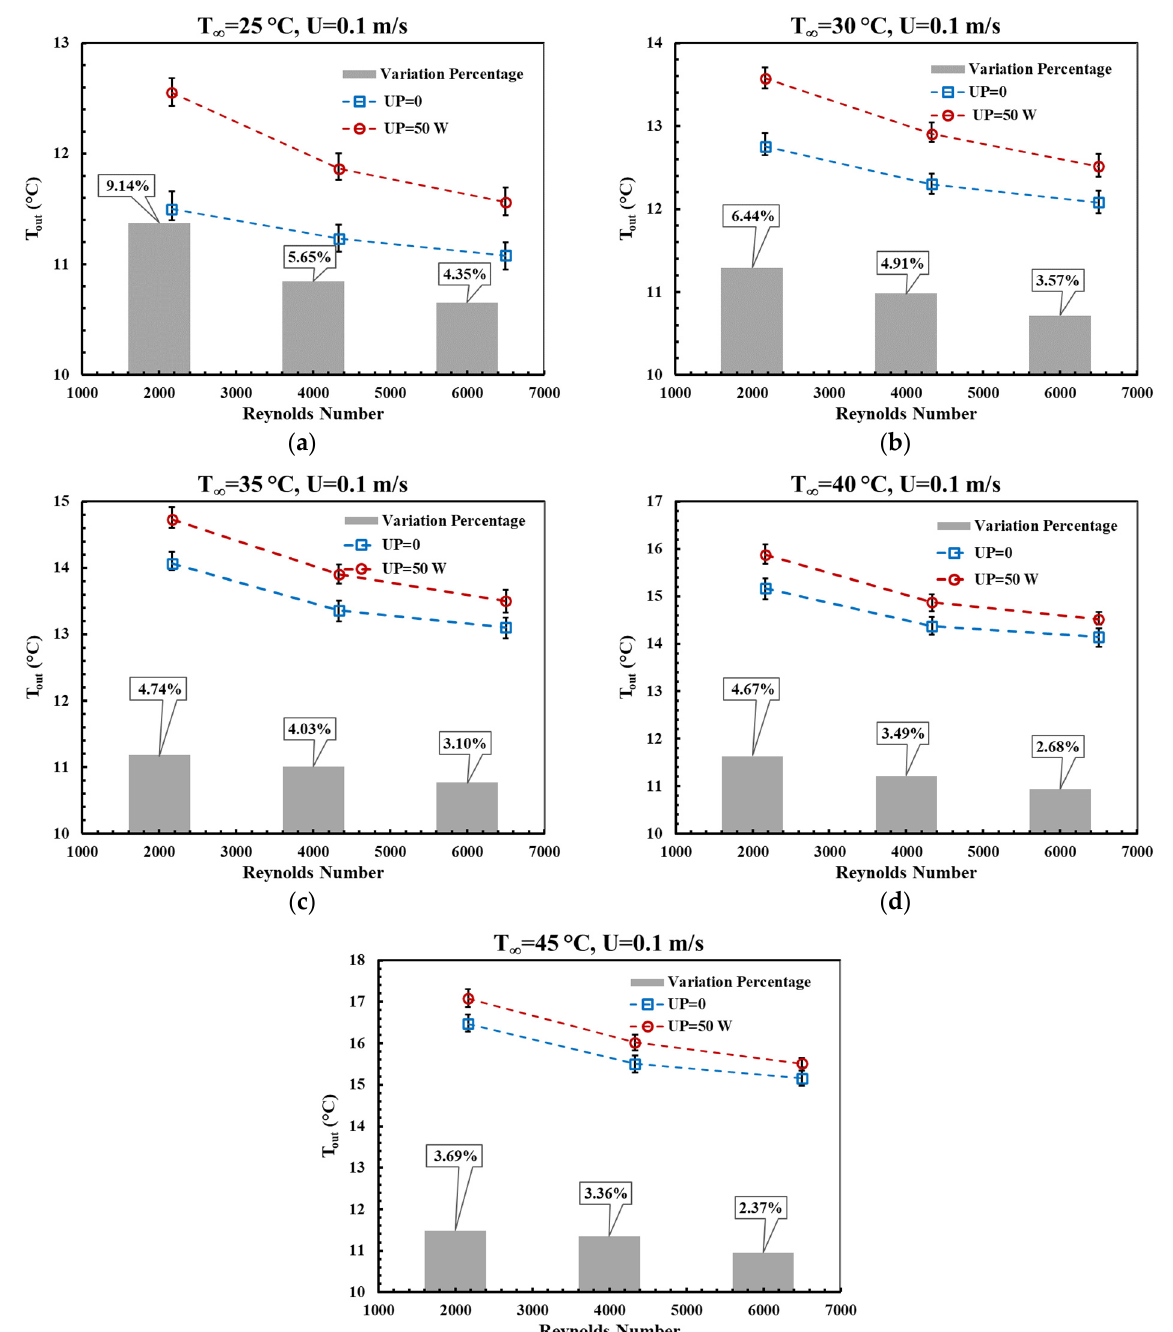
) and ( a ) 𝑻 (cid:2998) = 𝟐𝟓 (°𝐂), ( b ) ) and ( a ) T ∞ = 25 ( ◦ C), 𝒔 s